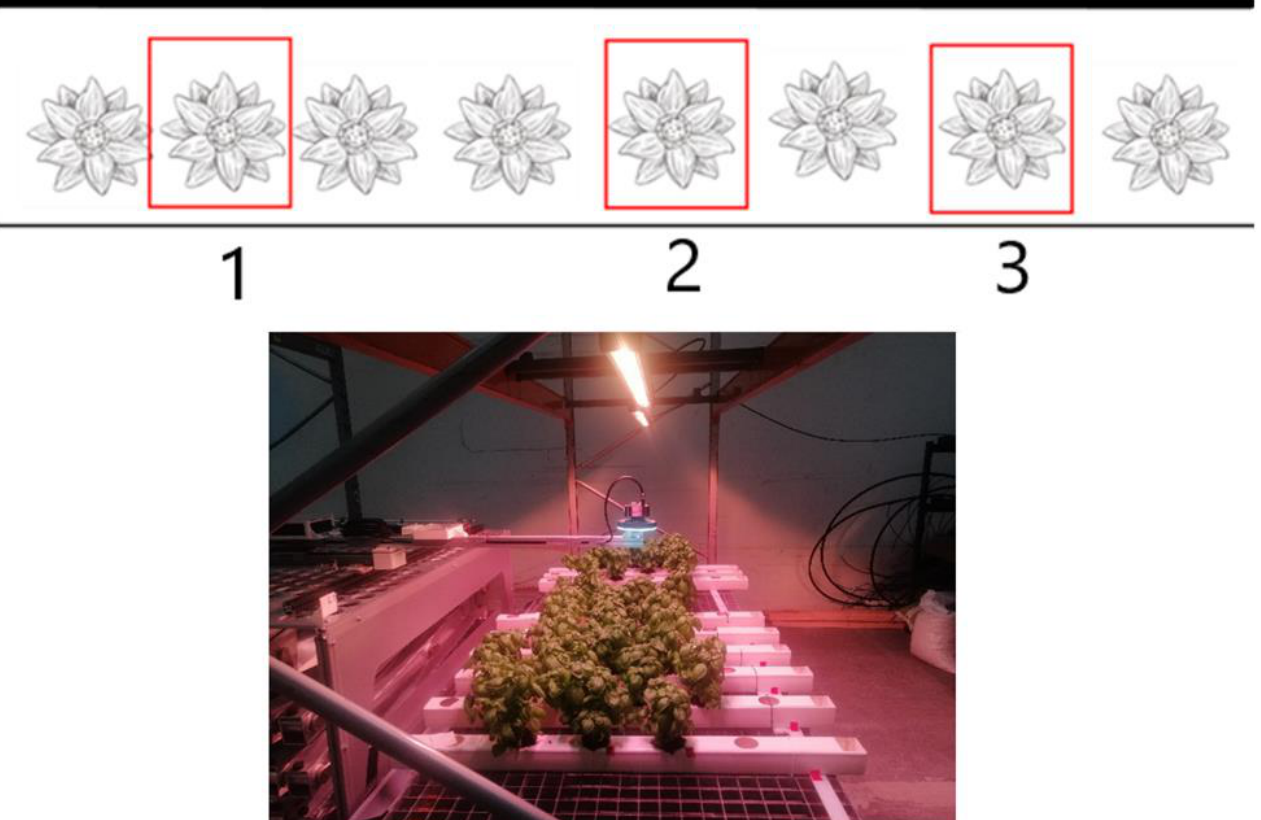
Figure 3. Visual representation of the sampling positions 1-3 with the red boxes in each treatment ( top ); Experimental setup: The robot of Seasony, Watney, with the attached mechanic arm, and the multispectral camera scanning the basil plants ( bottom ).